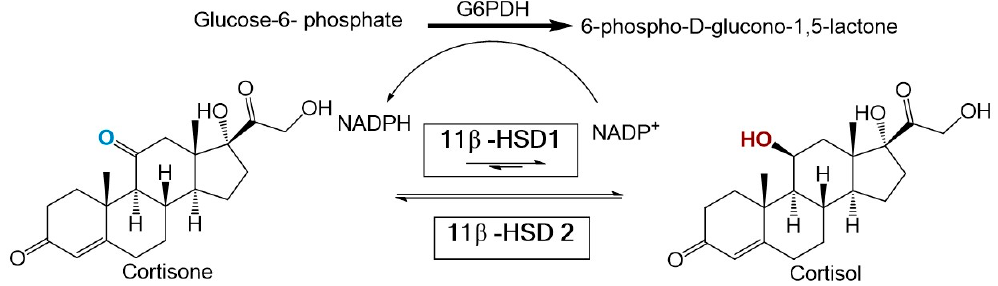
Figure 1. Chemical reactions facilitated by the enzymes 11b-Hydroxysteroid dehydrogenase type 1 and 2. A cofactor regeneration system based on gluocose-6-phosphate dehydrogenase is also illustrated.